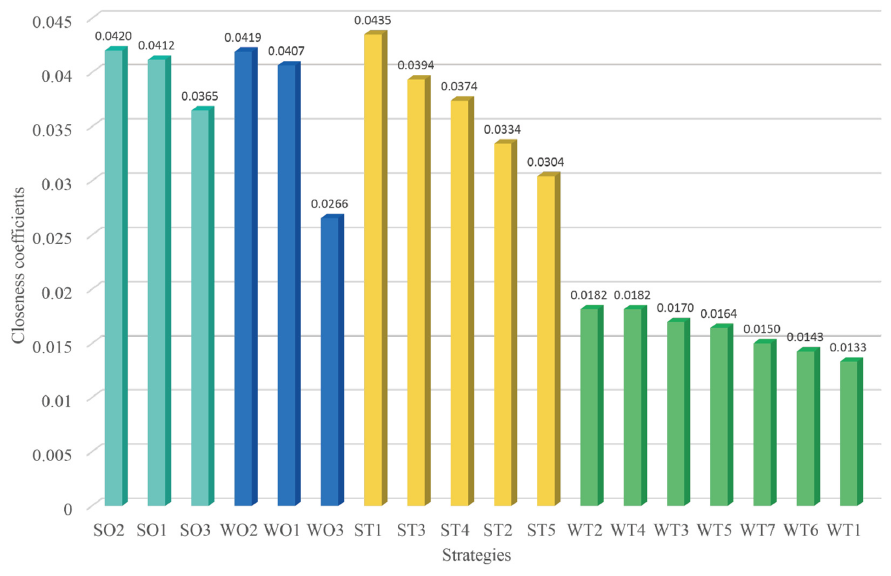
Figure 6. The priority ranking of strategies SO, WO, ST, and WT.